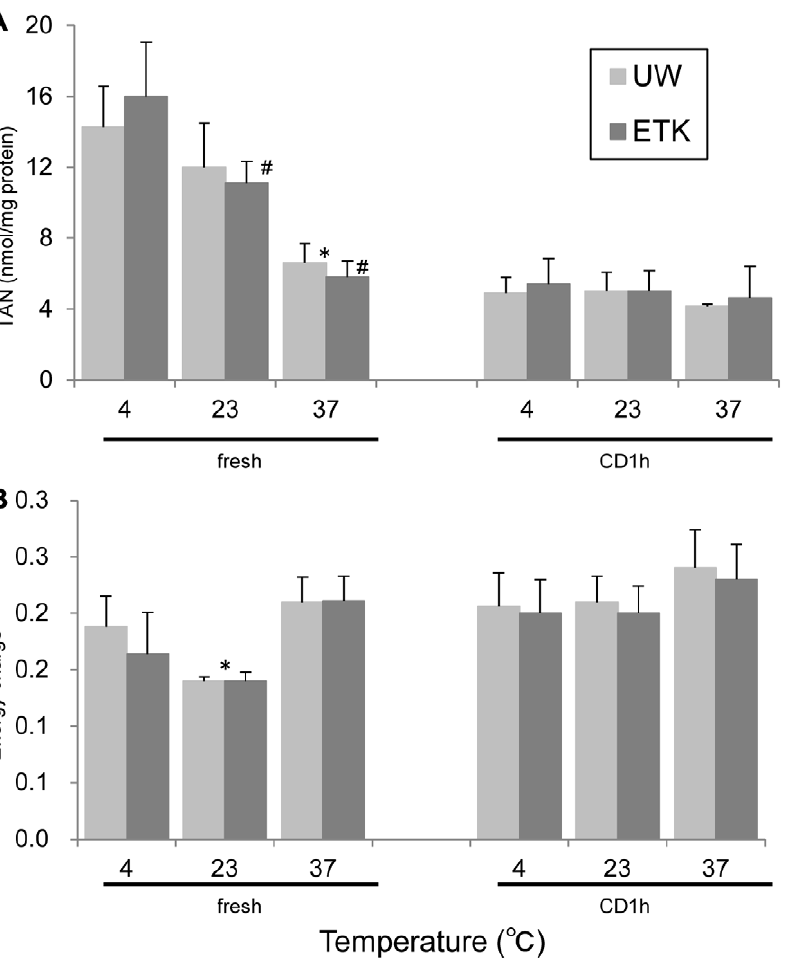
Figure 6. Impact of each preservation solution and temperature on tissue TAN and EC of preserved rat kidney. (A): The TAN of fresh kidneys at 37 u C and CD1h at all temperatures were lower than that of fresh kidneys at 4 u C and 23 u C (* p , 0.05, fresh37 vs. fresh4 in UW; # p , 0.05, fresh37 vs. fresh4 and 23 in ETK). (B) The EC of the fresh37, CD1h4, CD1h23, and CD1h37 groups was not higher than that of the fresh4 and fresh23 groups. The EC of fresh23 with UW preservation was significantly lower than that of fresh4 (* p ,